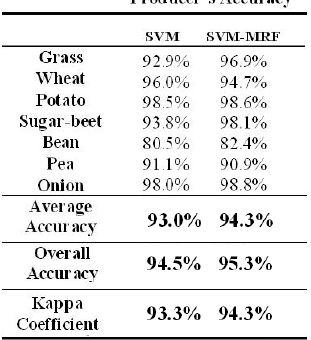
Figure 4. Temperature and total energy state of an image according to iterations of S.A method